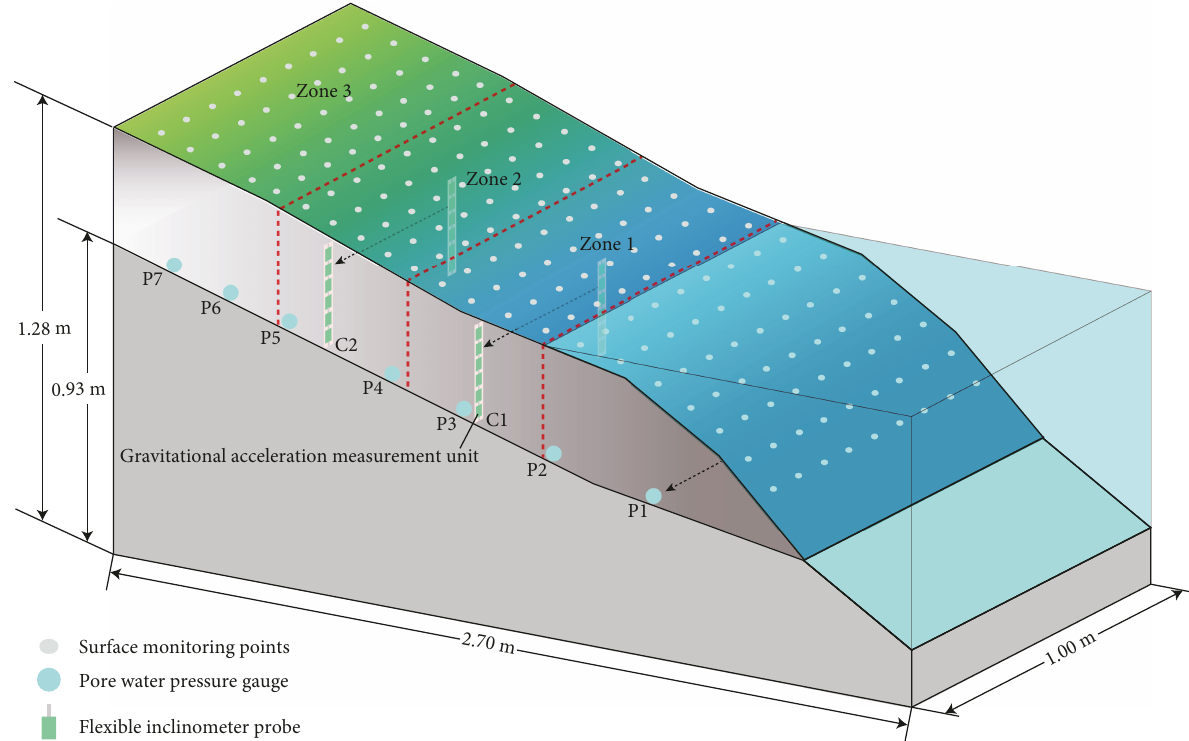
Figure 5: Monitoring in the model test.